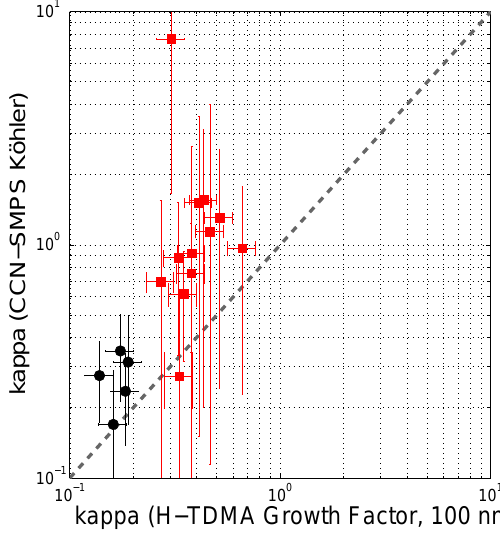
Fig. 7. κ is calculated with CCN-SMPS (K¨ohler) and H-TDMA particle growth factors. Line shown is 1:1. See Fig. 6 caption for error